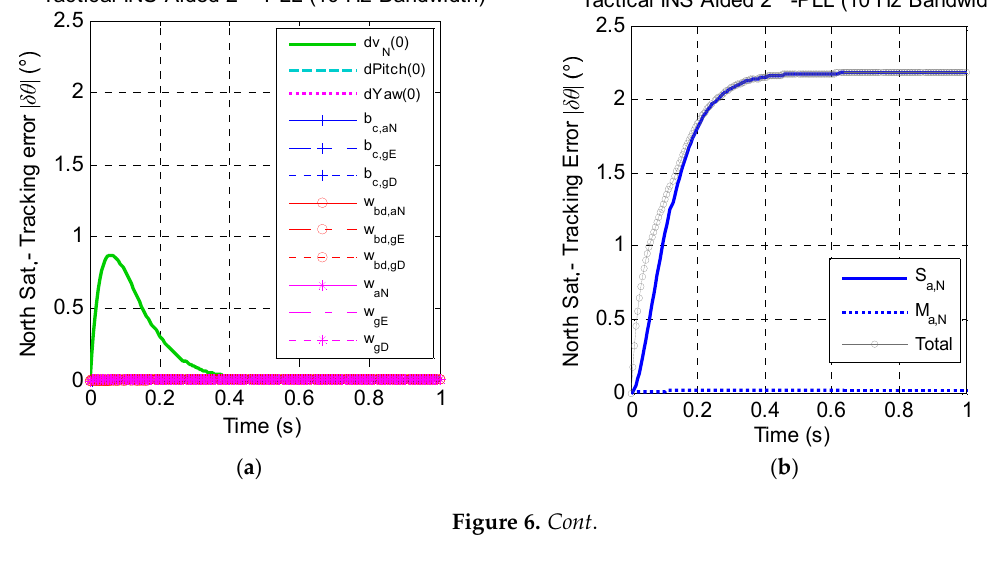
Figure 5. The north satellite tracking error caused by MEMS INS error sources under the assumption of linear high dynamics along the north direction. ( a ) Effect of non-maneuver-dependent error with a 10-Hz bandwidth; ( b ) effect of maneuver-dependent error with a 10-Hz bandwidth; ( c ) effect of non- maneuver-dependent error with a 20-Hz bandwidth; ( d ) effect of maneuver-dependent error with a 20-Hz bandwidth. PLL, phase-locked loop. (* Here, Sat. is the abbreviation of satellite.)